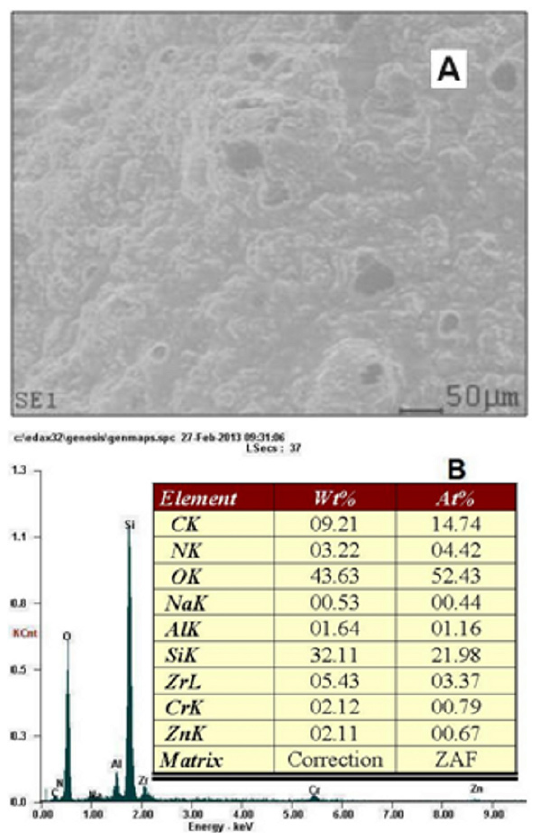
Figure 5. SEM/EDX